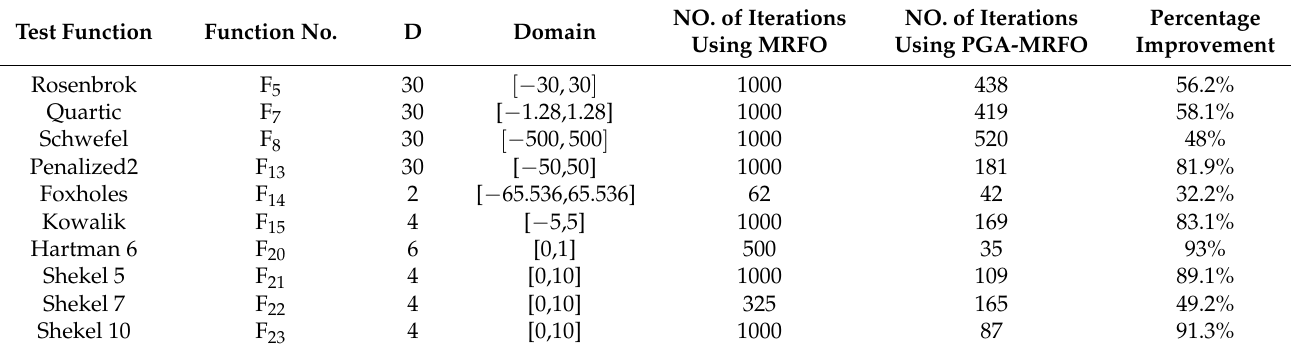
Table 1. Comparison between the two algorithms according to the consumed